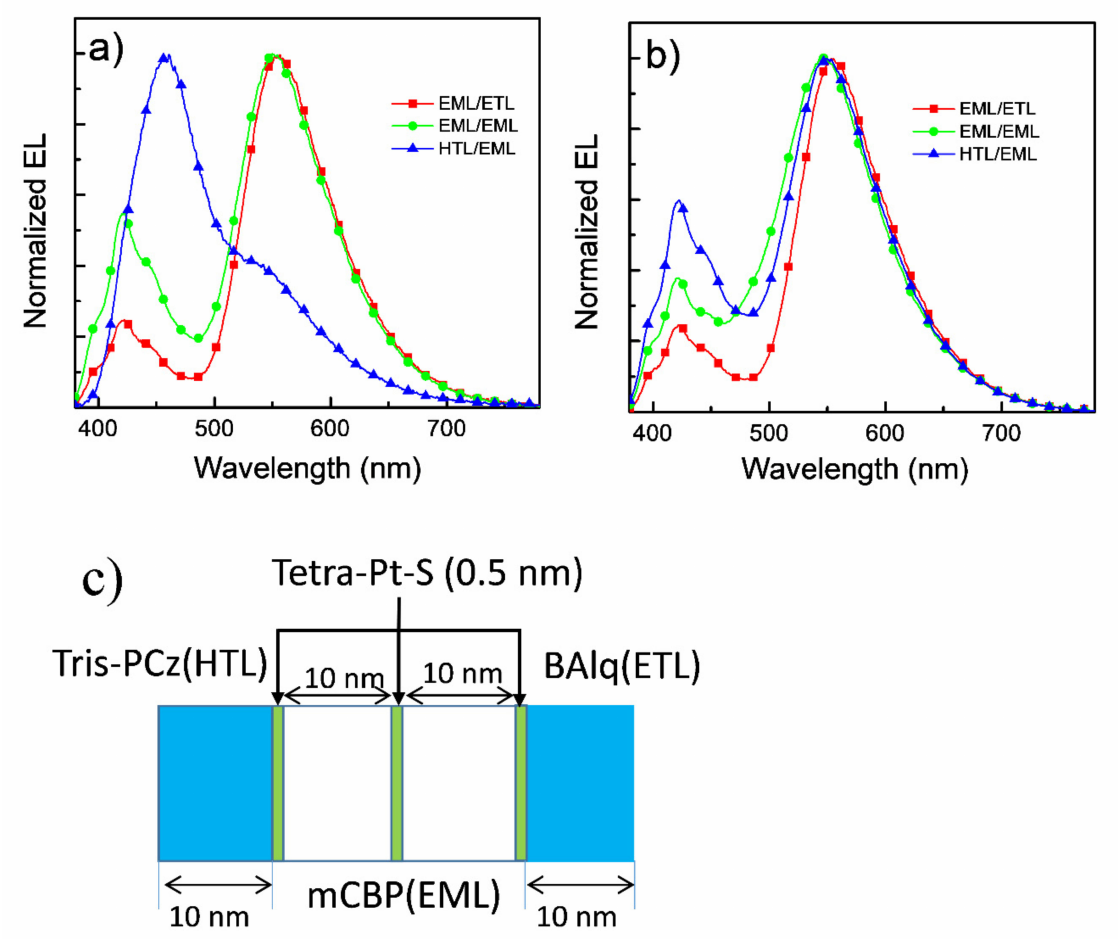
Figure 4. Normalized EL spectra of organic light-emitting diodes (OLEDs) with ( a ) non-doped electron transport layer (ETL) and ( b ) 50%-Liq-doped ETL. A 0.5-nm-thick layer of tetra-Pt-S was inserted in a 20-nm-thick non-doped mCBP emissive layer (EML) at different positions in both devices. ( c ) Schematic diagram of the locations of the tetra-Pt-S